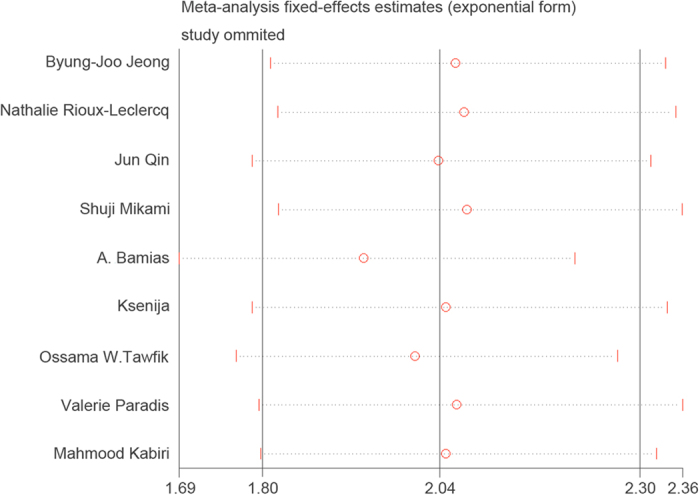
Sensitivity analysis of all the studies assessing 5-year OS rate.